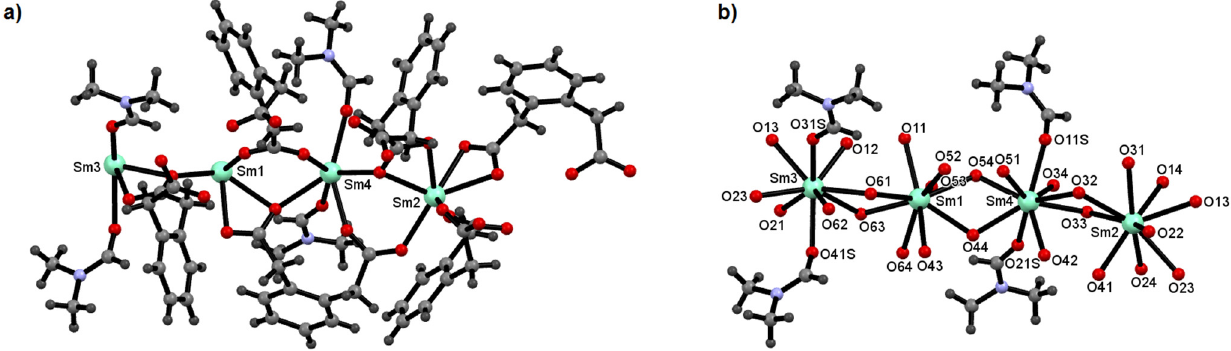
Figure 3. ( a ) Asymmetric unit of complex 2 . ( b ) Coordination environment of samarium atoms in 2 with emphasized DMF molecules.